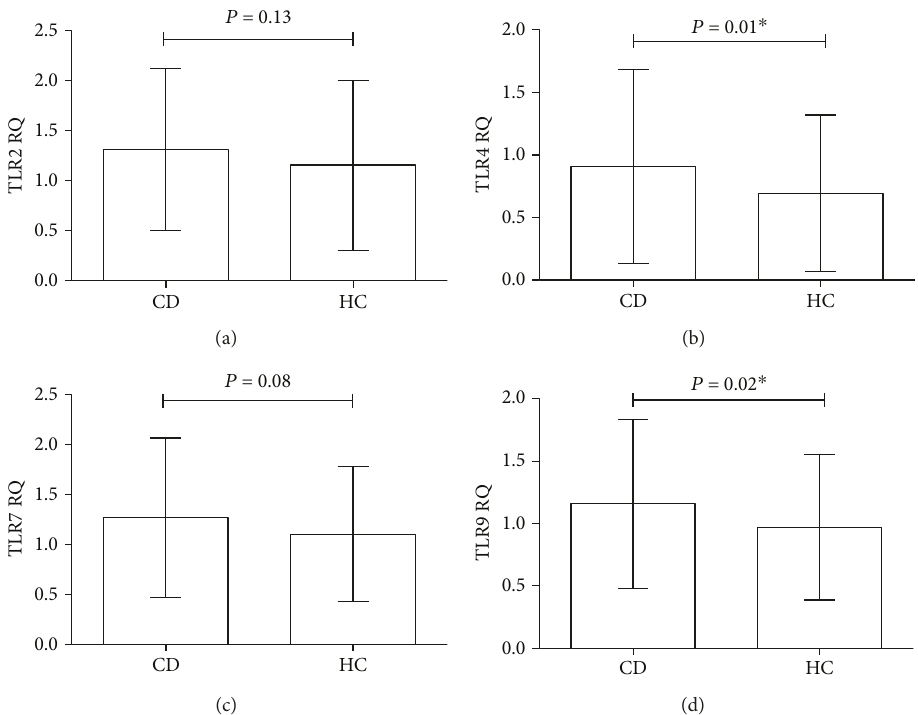
Figure 1: The relative expression of Toll-like receptors (TLRs) mRNA in peripheral blood specimens. Analysis of signi fi cance was performed by Student ’ s t -test. (a) TLR2, (b) TLR4, (c) TLR7, and (d) TLR9. ∗ P value is signi fi cant.